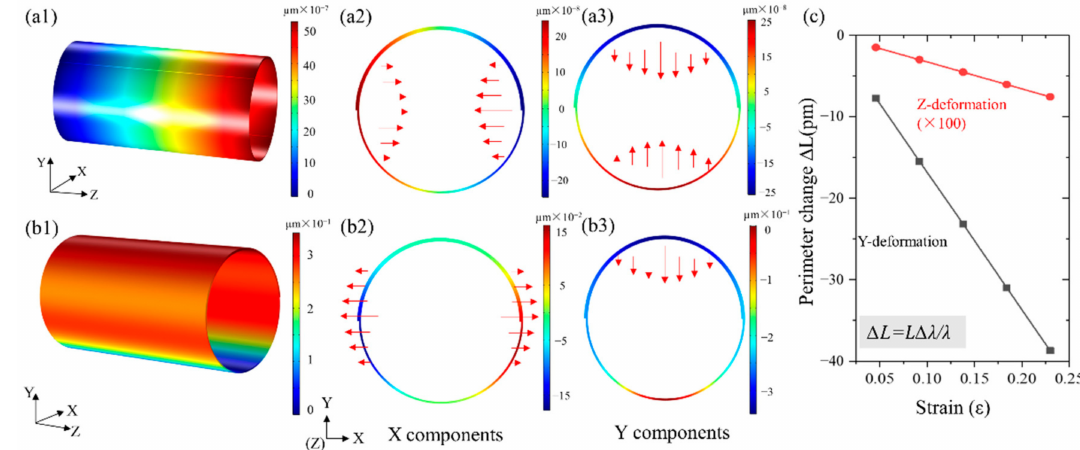
Figure 6. ( a1 ) The 3D deformation distribution under 0.05 ε tensile strain from the Z direction. ( a2 , a3 ) the cross-sectional deformation magnitude of the X component and the Y component, respectively. ( b1 ) The 3D deformation distribution under − 0.05 ε compressive strain from the Z direction. ( b2 , b3 ) the cross-sectional deformation magnitude of the X component and the Y components, respectively. ( c ) Simulated microtubule circumference variation as a function of applied